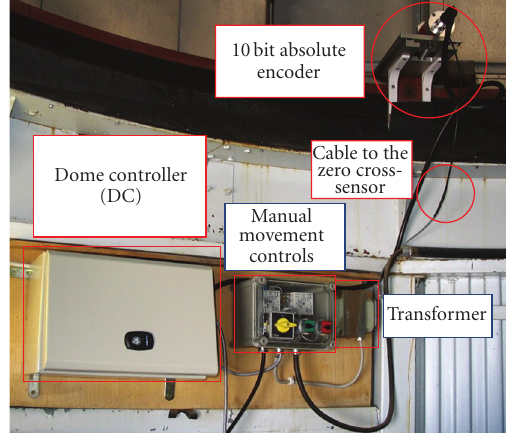
Figure 6: Interior of the Dome Controller (DC), showing its di ff er- ent boards and